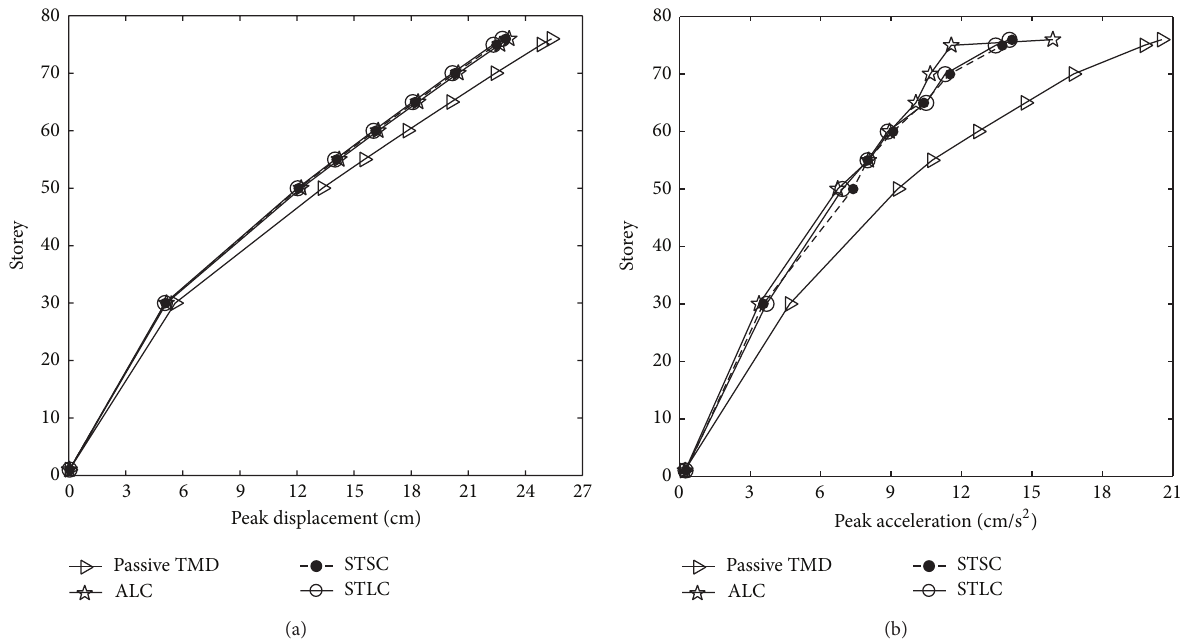
Figure 7: Comparison of peak displacement and peak acceleration ( 0 % stiffness